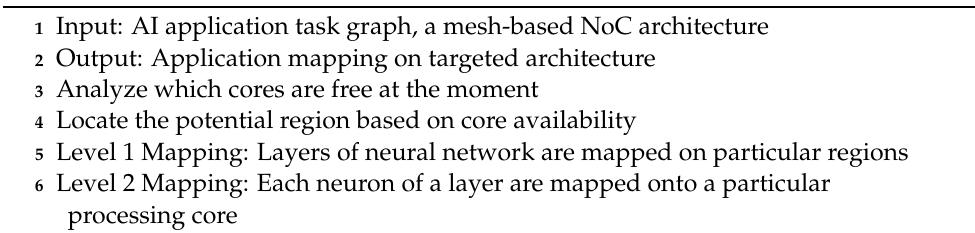
Algorithm 1: AI application mapping on mesh-based